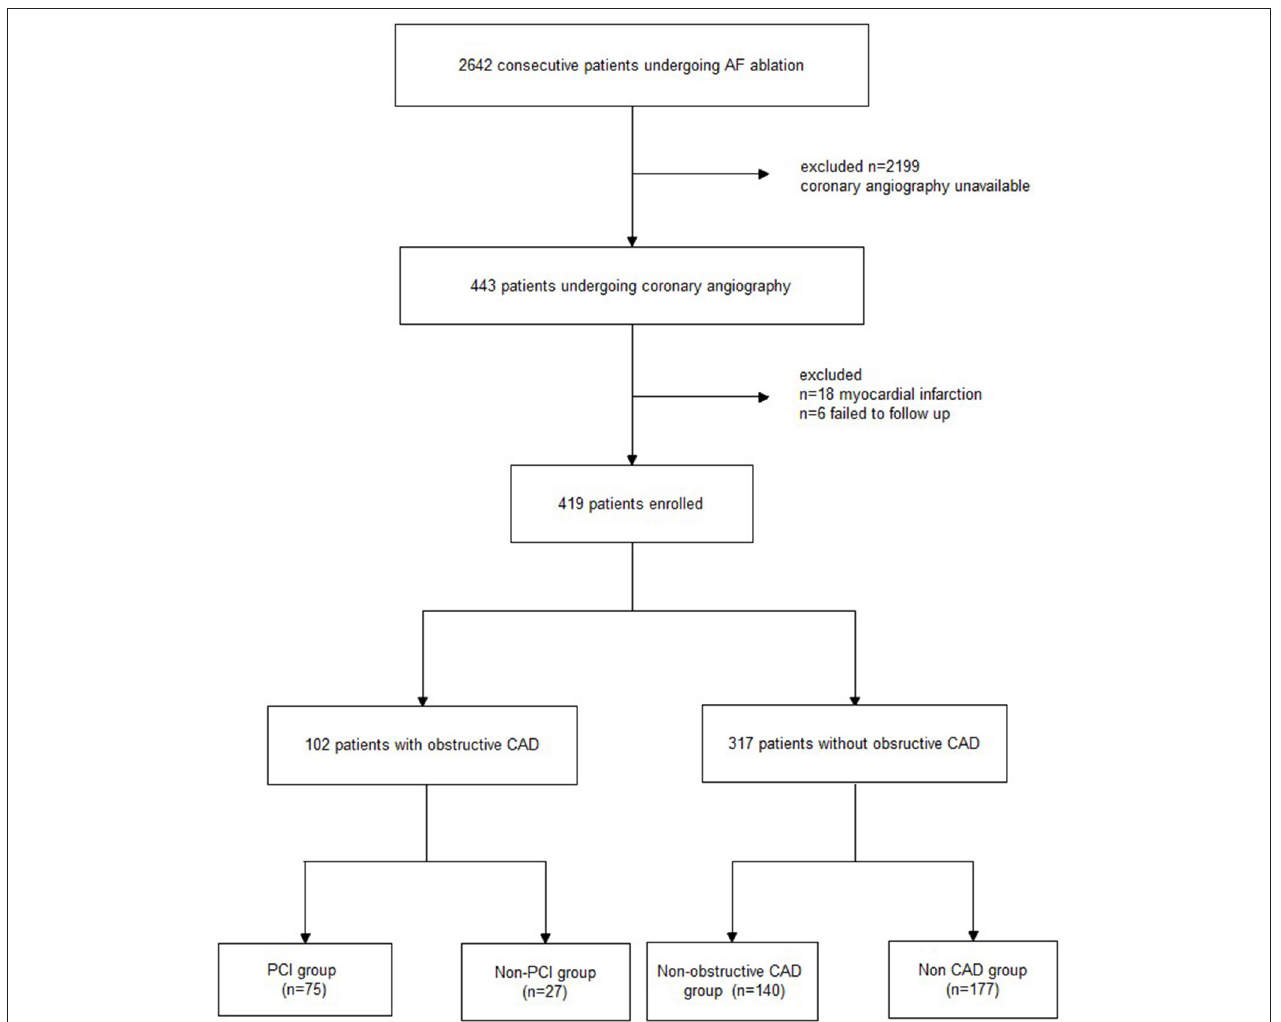
FIGURE 1 | Study flowchart. AF, atrial fibrillation; CAD, coronary artery disease; PCI, percutaneous coronary